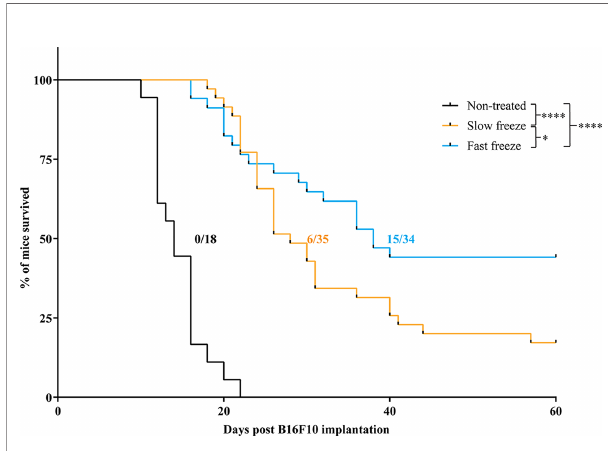
FIGURE 1 | Survival of melanoma bearing mice treated with cryoablation at slow freeze or fast freeze rates. Mice were transplanted with 5 x 10 6 B16F10 melanoma cells sub-cutaneously on day 1 and received cryoablation between days 7-9. Kaplan-Meier survival curves of mice treated with slow freeze or fast freeze, along with non-treated controls. Data obtained from four independent experiments. Non-treated controls (n = 18), slow freeze (n = 35), fast freeze (n = 34). Numbers displayed on the graph indicate the no. of tumor-free surviving mice/total no. of mice employed for each group. Survival curves were analyzed using log-rank (Mantel-Cox) test. * P < 0.05, **** P <